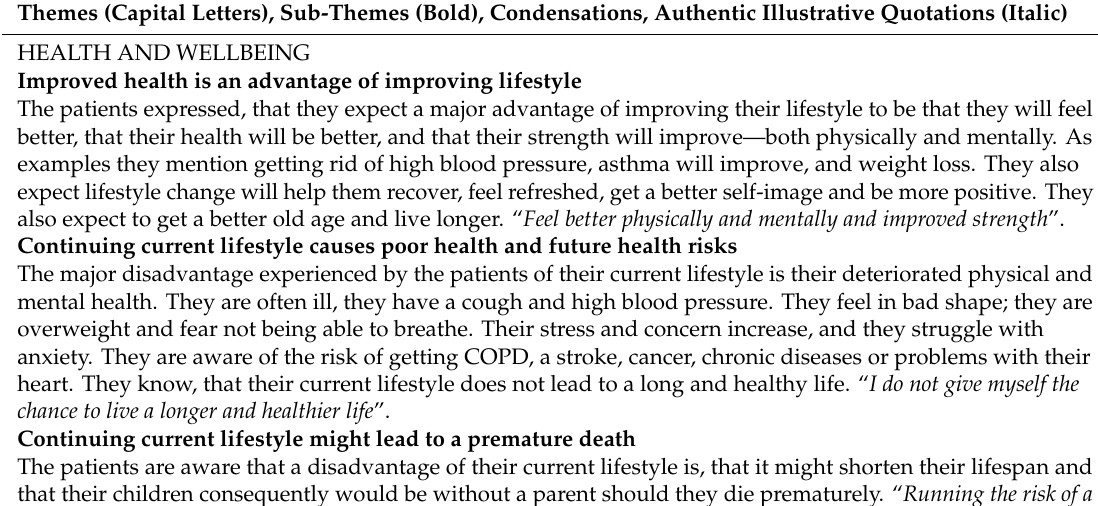
Table 3. Reflections on advantages and disadvantages of lifestyle